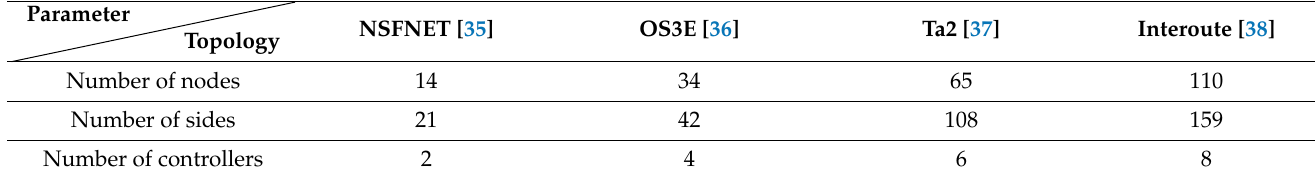
Table 2. Characteristics of